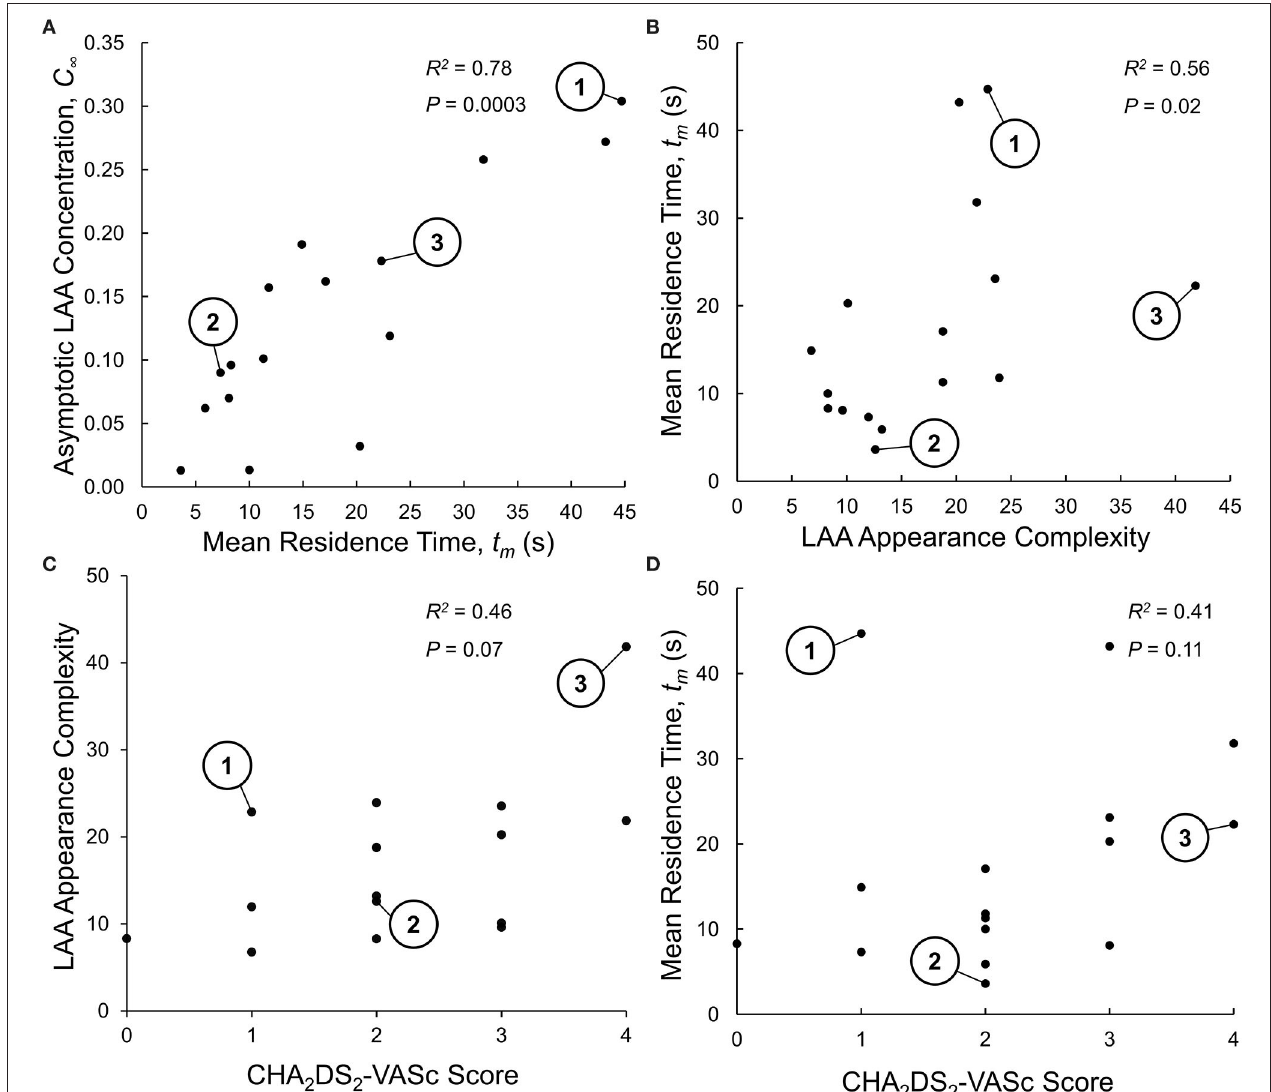
FIGURE 4 | (A) Relationship between the two indices of LAA residence time distribution (RTD) function: mean residence time, t m , and aymptotic LAA concentration, C ∞ . The Spearman rank correlation analysis indicates that LAA t m and C ∞ are highly correlated, suggesting that only one of these indices is sufficent to characterizie the LAA RTD function. The three representative subjects shown in Figures 2 , 3 are identified. (B) Relationship between LAA appearance complexity index (LAA- ACI ) and LAA t m . The Spearman rank correlation analysis indicates a weak (although statistically significant) correlation, suggesting that these two variables do not provide the same infoamtion. (C) Relationship between LAA- ACI and CHA 2 DS 2 -VASc score, analyzed using Spearman rank correlation analysis, showing a weak and insignificant correlation. (D) Relationship between LAA t m and CHA 2 DS 2 -VASc score, analyzed using Spearman rank correlation analysis, showing a weak and insignificant